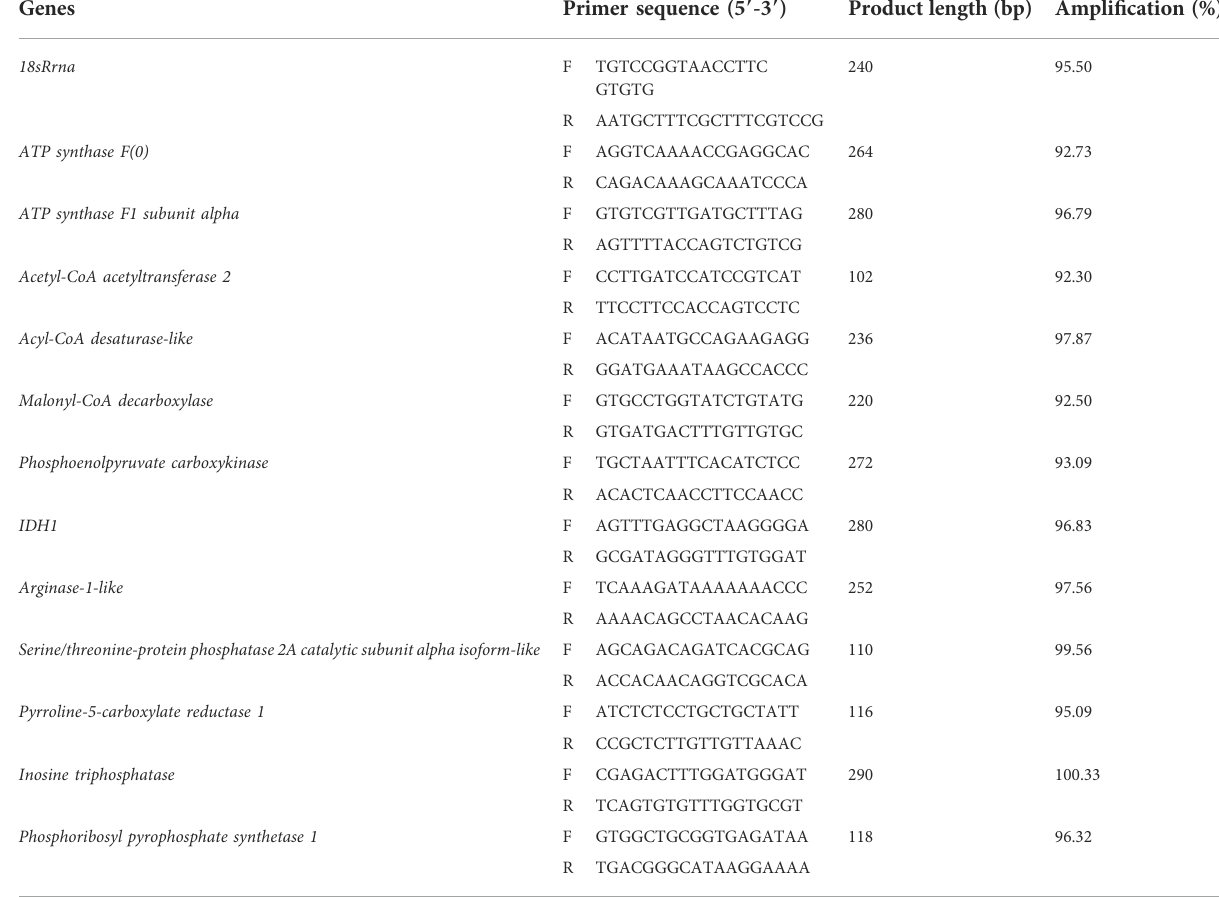
TABLE 1 Primer sequences used for